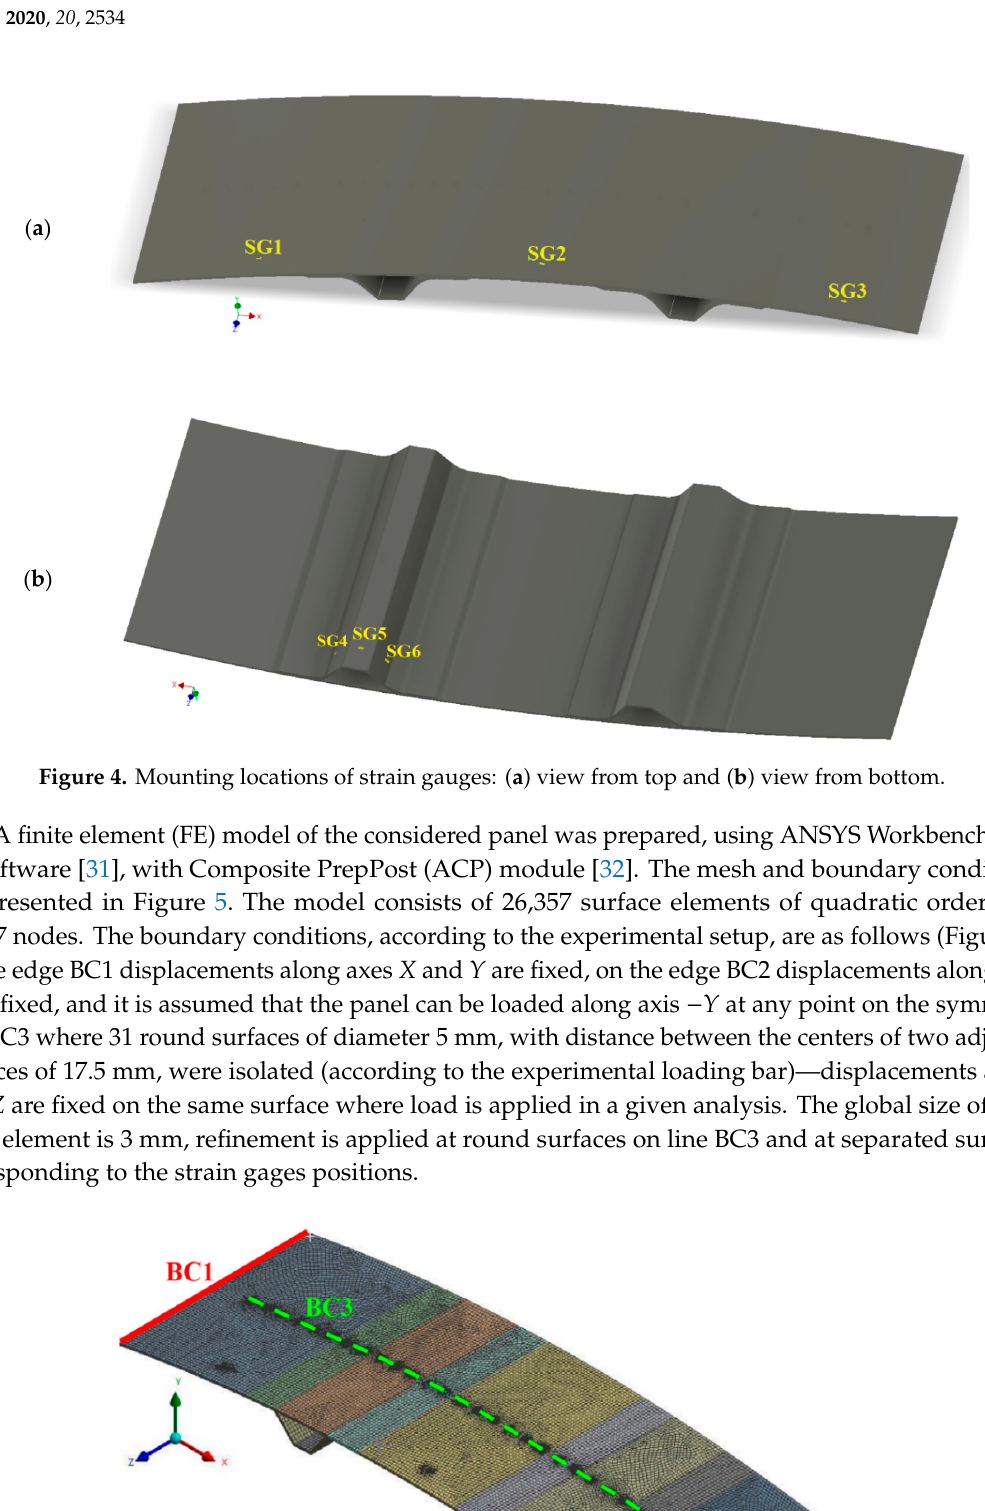
Figure 5. Mesh and boundary conditions of the finite element model of the omega-stiffened composite panel.